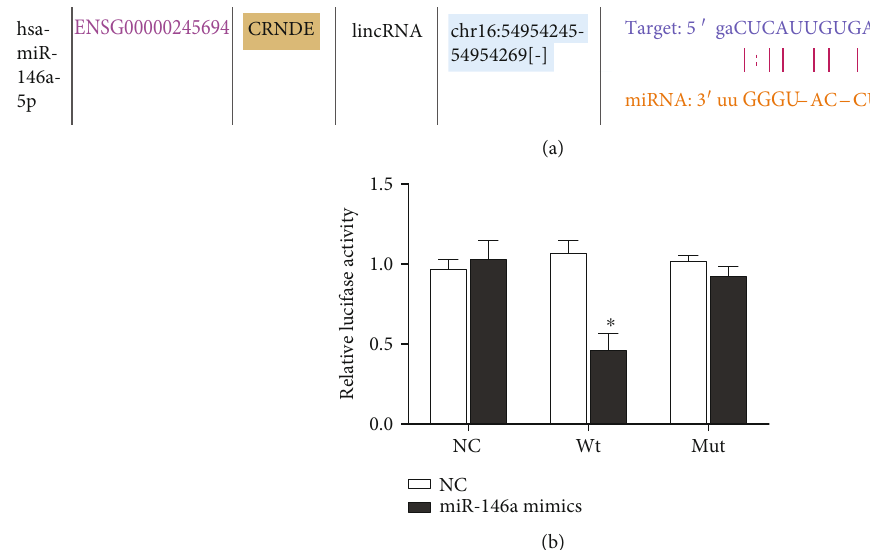
Figure 4: mir-146a was the target gene of CRNDE, ∗ p < 0 : 05